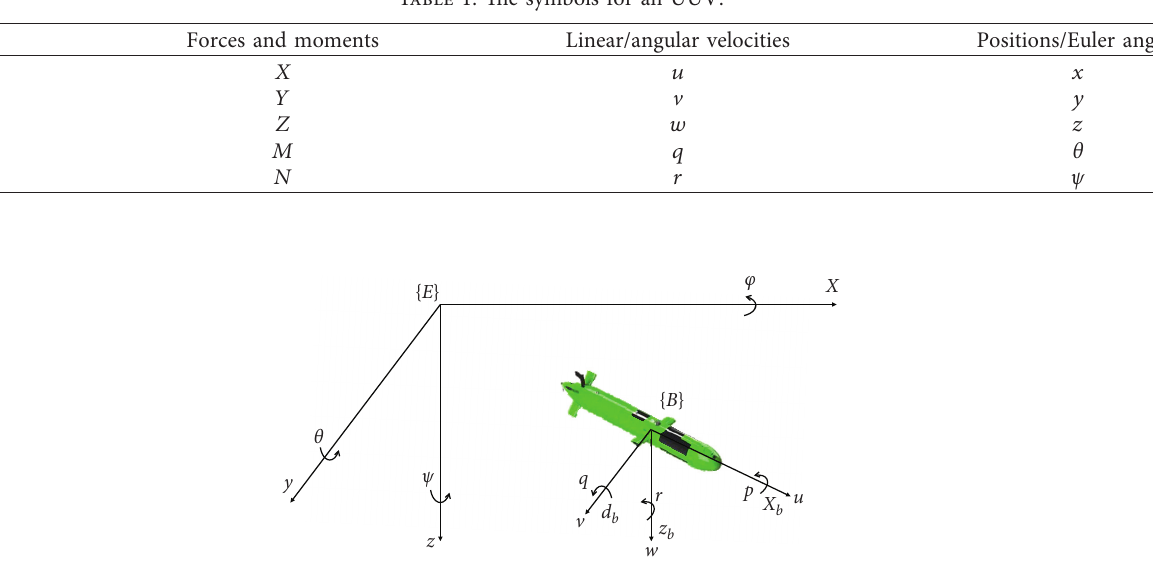
Figure 1: The body-fixed and earth-fixed coordinate systems for an